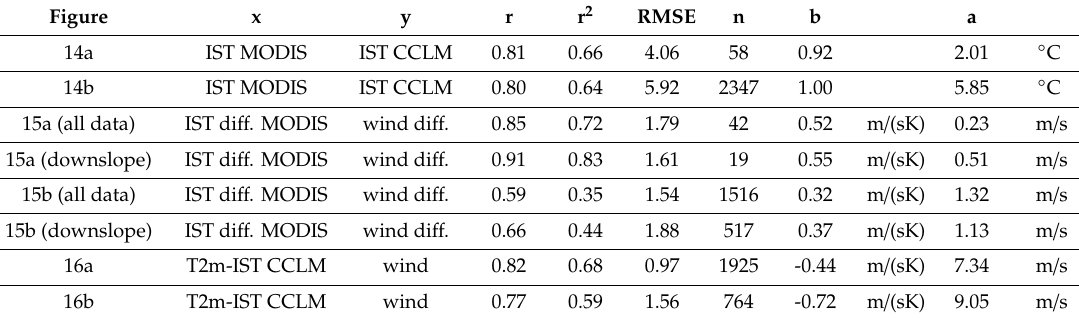
Table 1. Statistics for the linear regressions (y = a + bx) of the di ff erent Figures (n = number of values, a = interception, b = slope, with dimensions). Wind is always from CCLM. All regressions are significant with a p value less than